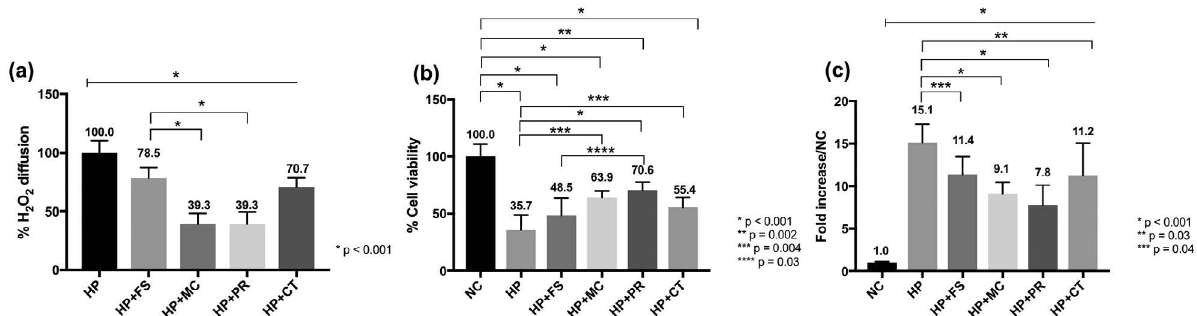
Figure 2- (a), (b), and (c) Bar graph of mean values (standard deviation) of cell viability percentages (MTT assay), fold increase in carboxy-H2DCFDA fluorescence (oxidative stress), and residual H2O2 percentages (violet leuco-crystal/peroxidase assay), respectively. Numbers are mean values for each